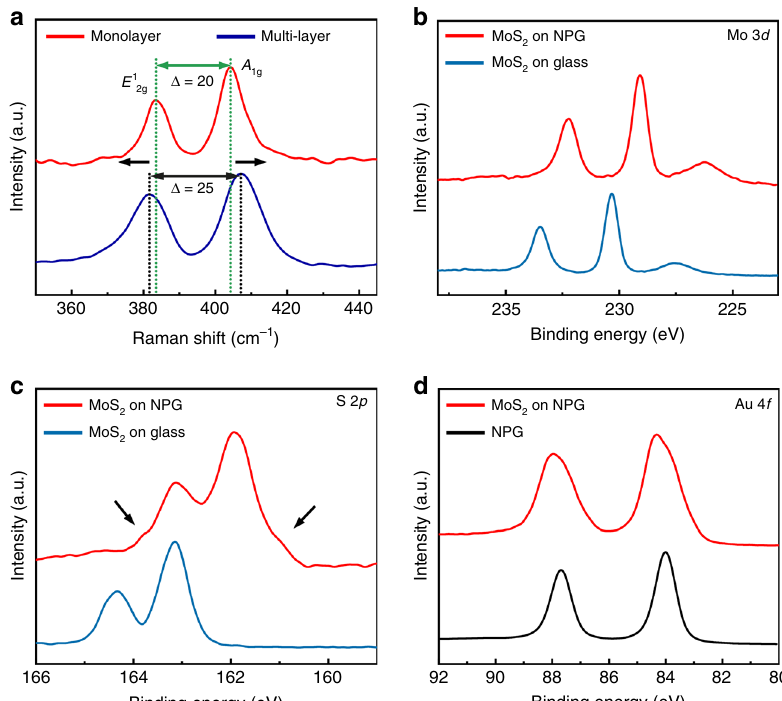
Fig. 2 Raman and XPS characterizations of MoS 2 growing on NPG. a Raman spectra of monolayer and multi-layer MoS 2 on NPG. b Mo 3 d and c S 2 p core-level peaks of MoS 2 grown on NPG and glass. d Au 4 f core-level peaks of original NPG and MoS 2 grown on NPG.